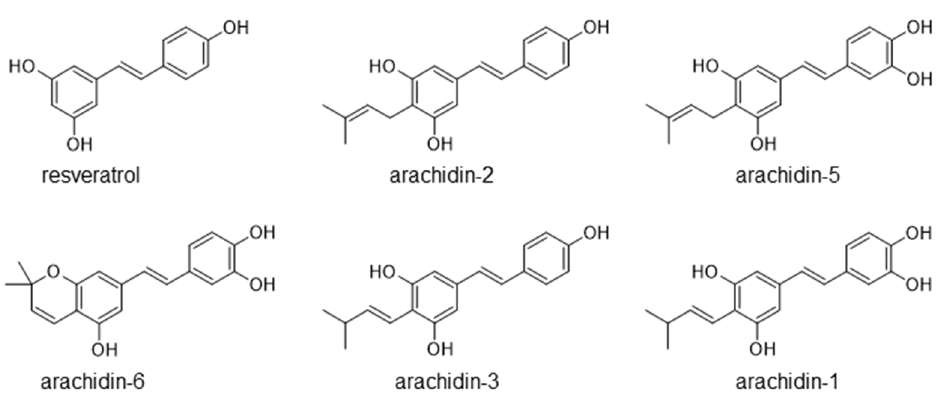
Figure 1. Chemical structure of six main stilbenoids found in elicited peanut hairy root culture. All compounds are shown in their trans -isomer.